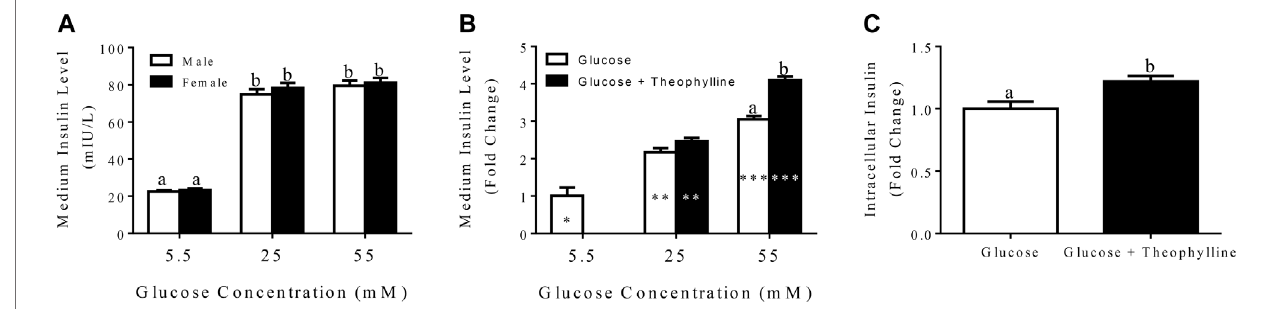
FIGURE 7 | Medium insulin levels (LS mean ± SEM) following incubation of differentiated clusters with KRB buffer containing distinct glucose concentrations (A) . Fold change (LS mean ± SEM) in medium insulin levels relative to 5.5 mM glucose following incubation of differentiated clusters with KRB buffer containing distinct glucose concentrations with and without theophylline (B) , and intracellular insulin levels (LS mean ± SEM) following cluster incubation in KRB buffer containing 55 mM glucosewith(blackbar)andwithout(whitebar)theophylline (C) .Columnswithdistinctsuperscriptsaresigni fi cantlydifferentbetweentheophyllinetreatmentswithin glucose concentrations, and those with different asterisk (*) numbers are signi fi cantly different among glucose concentrations within theophylline treatments ( p < 0.05).